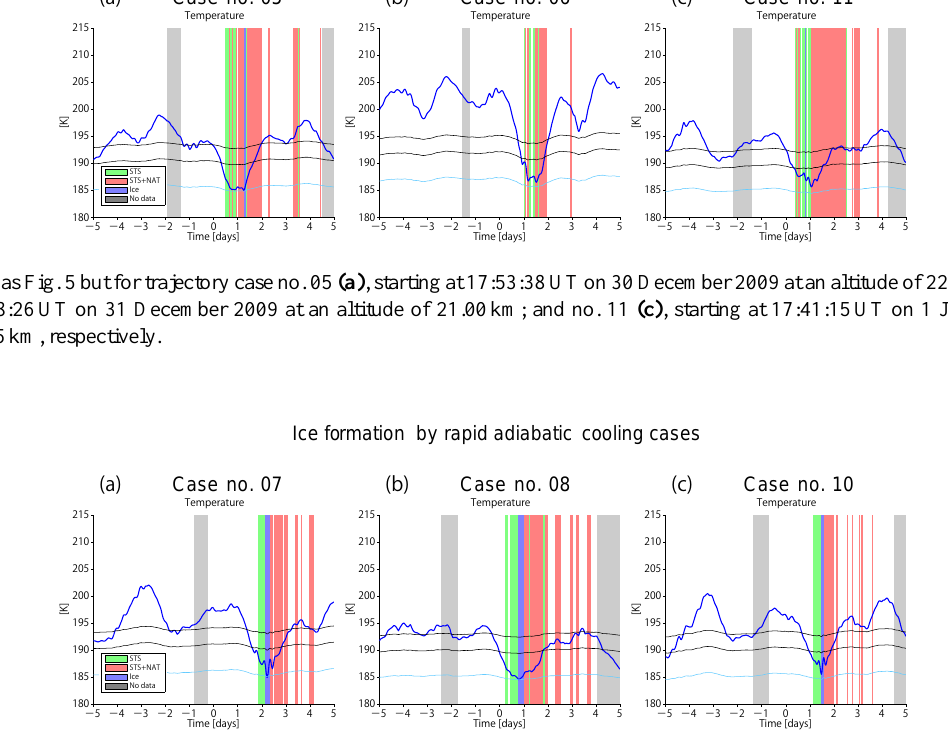
Figure 7. Same as Fig. 5 but for trajectory case no. 07 (a) , starting at 12:10:25UT on 31 December 2009 at an altitude of 22.15km; no. 08 (b) , starting at 16:59:14UT on 31 December 2009 at an altitude of 24.05km; and no. 10 (c) , starting at 09:39:12UT on 1 January 2010 at an altitude of 22.97km,